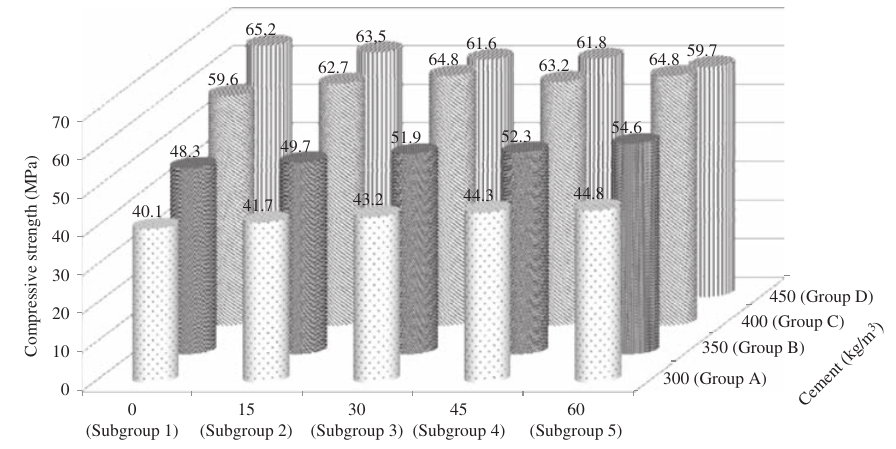
Figure 5 Compressive strength of